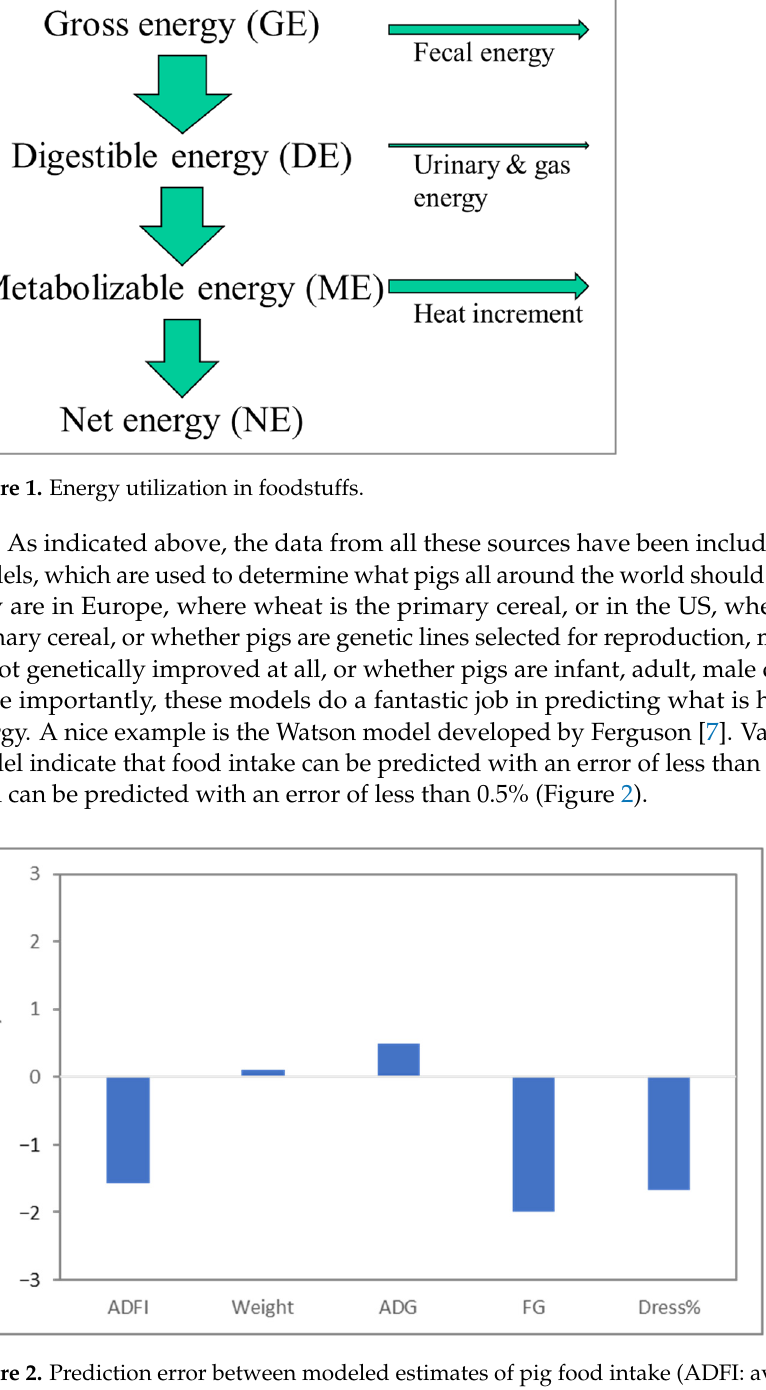
Figure 2. Prediction error between modeled estimates of pig food intake (ADFI: average daily food intake), gain (ADG: average daily gain), weight, efficiency of conversion of food into weight gain (FG: ADFI/ADG ratio) and dressing percentage (Dress%: yield of carcass as percentage of body weight). Ferguson, personal communication.